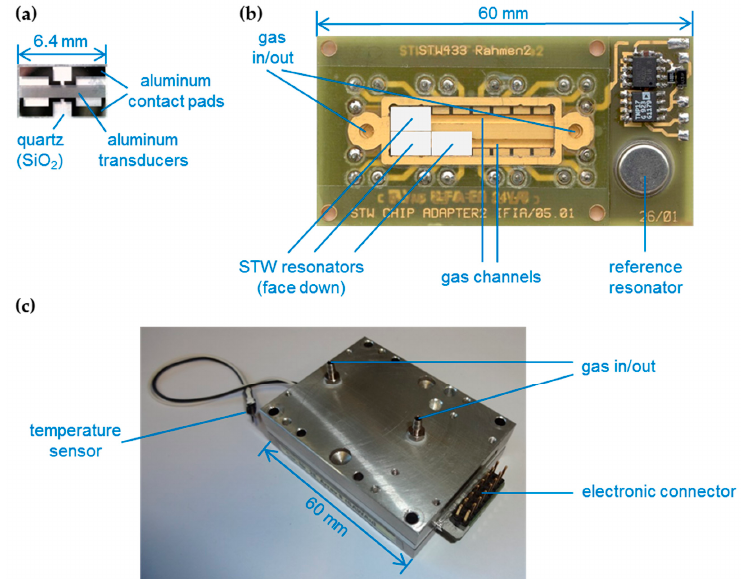
Figure 1. ( a ) STW resonator, f 0 = 433 MHz, consisting of quartz substrate with aluminum transducers; ( b ) Sensor array with incorporated gold coated gas channels. The array is designed for eight